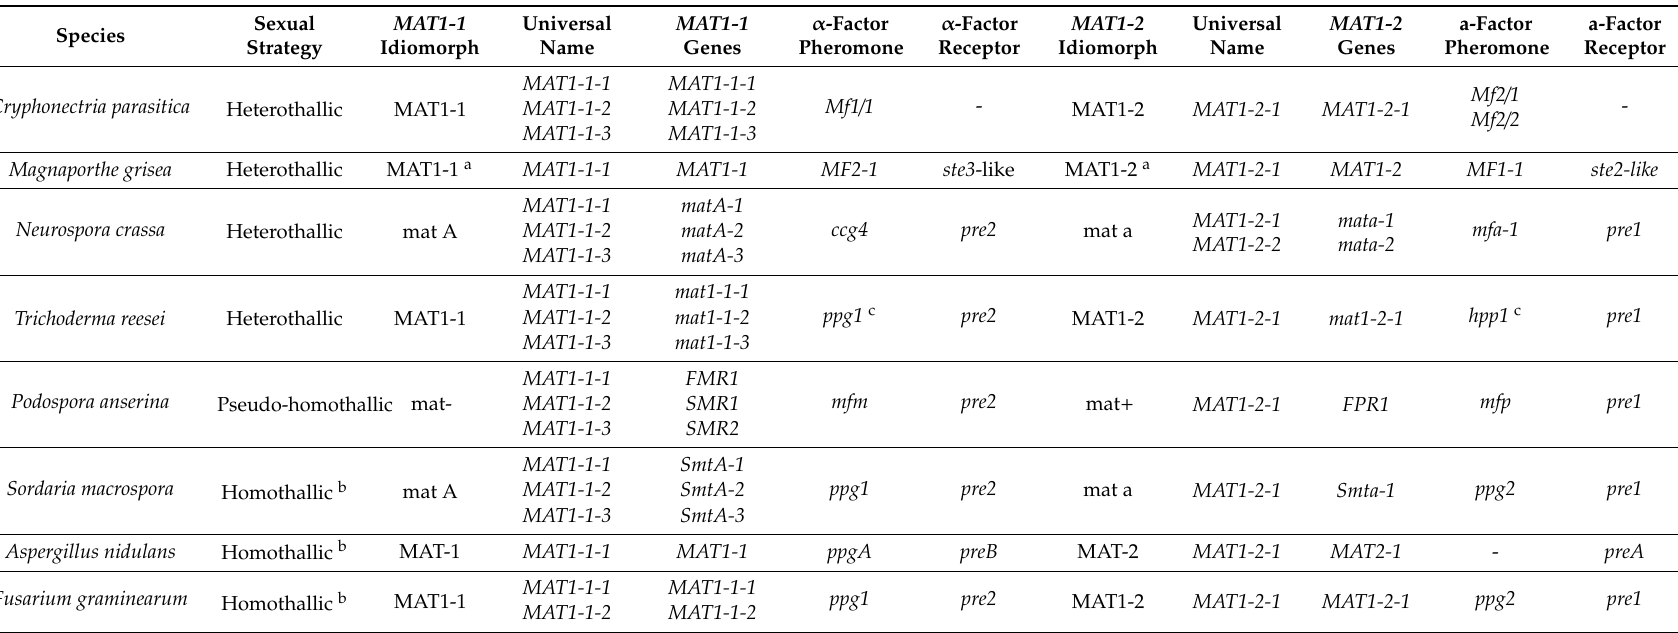
Table 1. The gene name equivalents of the MAT , pheromone, and pheromone receptor